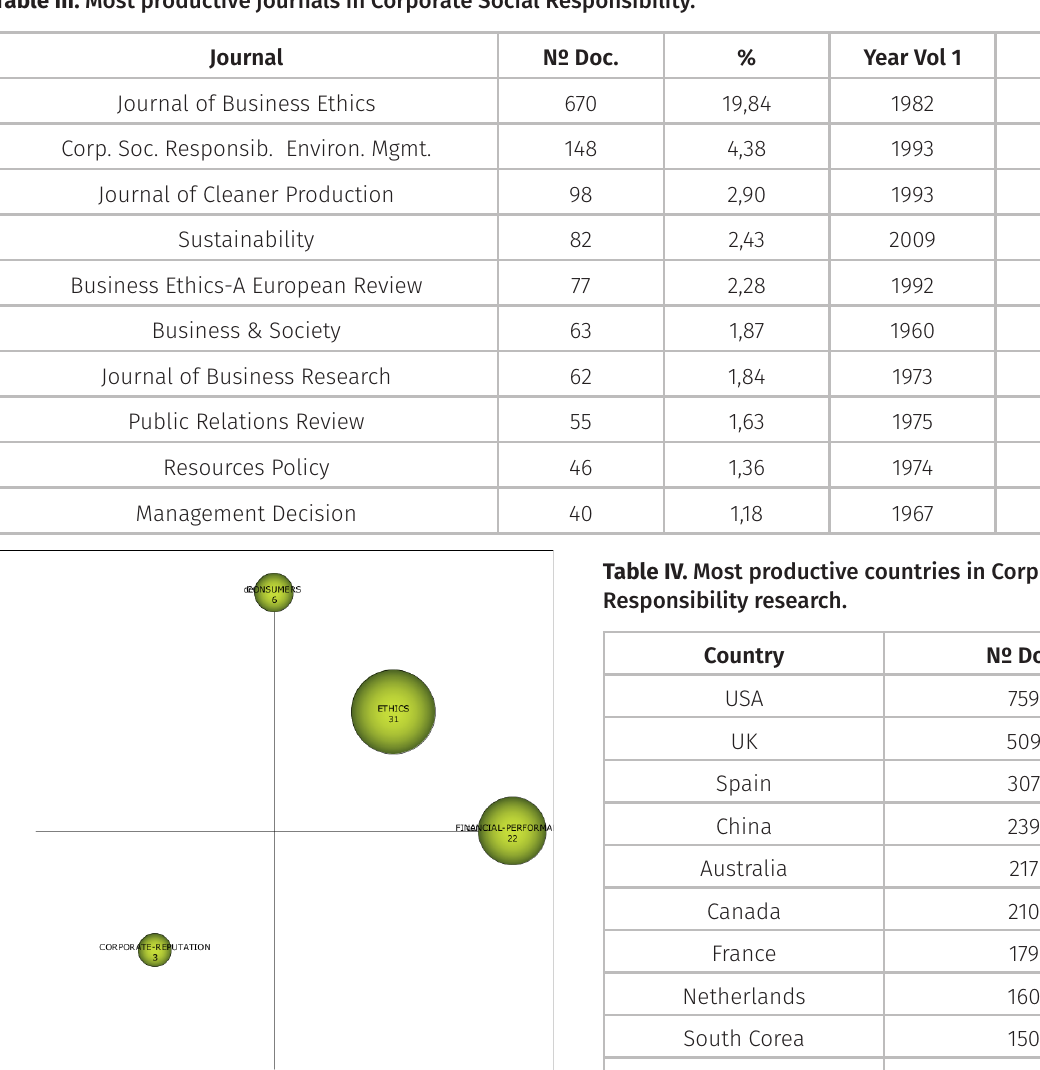
Table III. Most productive journals in Corporate Social Responsibility.